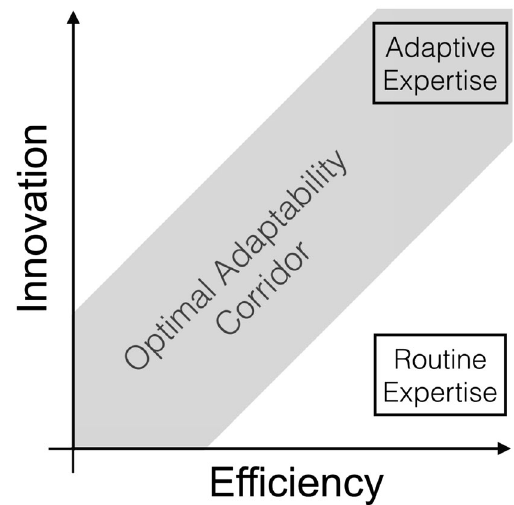
FIG. 8. Two courses of expertise plotted on a 2D space of innovation vs efficiency (adapted from Schwartz, Bransford, and Sears